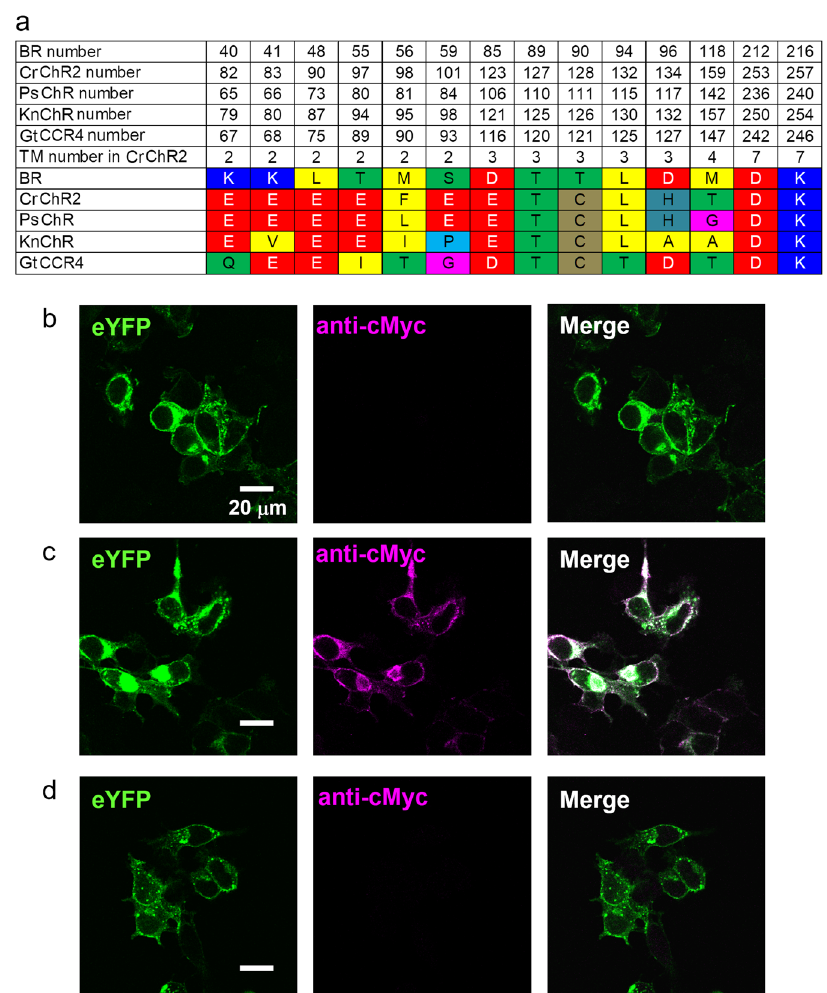
Fig. 1 Sequence comparison and determination of KnChR transmembrane topology and orientation. a Amino acid alignments of bacteriorhodopsin (BR), CrChR2 (Channelrhodopsin-2 from Chlamydomonas reinhardtii ), PsChR (Channelrhodopsin from Platymonas subcordiformis ), KnChR and GtCCR4 (Cation Channelrhodopsin-4 from Guillardia theta ). The characteristic amino acids in BR and CrChR2 were selected. In addition, amino acid numbers of each protein and transmembrane helix (TM) number are indicated. See Supplementary Fig. 1 for an alignment of the whole protein sequences. b Immunostaining of KnChR. Expression of KnChR-3.0-eYFP-cMyc in cultured ND7-23 cells, with KnChR bearing the c-Myc epitope tag at the C-terminus. eYFP fl uorescence (left, green), probed with a c-Myc antibody under non-permeabilized conditions for immuno fl uorescent staining with Alexa Fluor 594 (middle, magenta) and merge (right). Scale bar, 20 μ m. c Expression of KnChR-3.0-eYFP-cMyc in cultured ND7-23 cells. eYFP fl uorescence (left, green), probed with a c-Myc antibody under permeabilized conditions (0.5% Triton X-100) for immuno fl uorescent staining with Alexa Fluor 594 (middle, magenta) and merge (right). d Expression of KnChR-3.0-eYFP in cultured ND7-23 cells. eYFP fl uorescence (left, green), probed with a c-Myc antibody under permeabilized conditions (0.5% Triton X-100) for immuno fl uorescent staining with Alexa Fluor 594 (middle, magenta) and merge